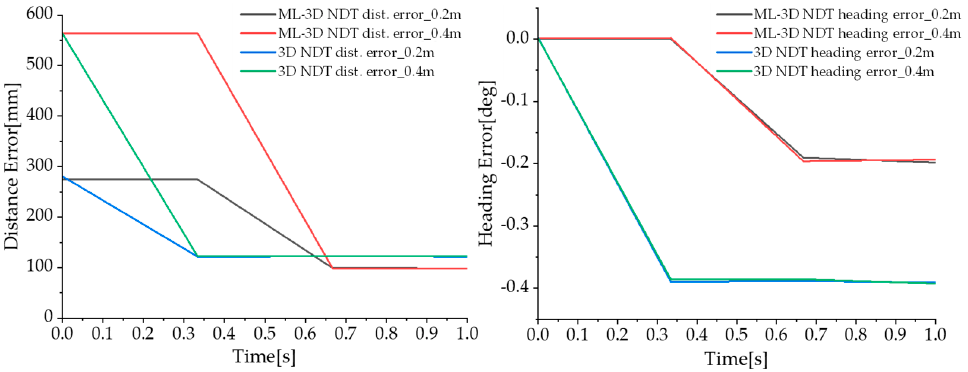
Figure 7. Result of the scenario 2-2 in terms of localization accuracy. Table 3. Result of the comparative study of 3D NDT and ML 3D NDT in scenario 1-2 and 2-2.